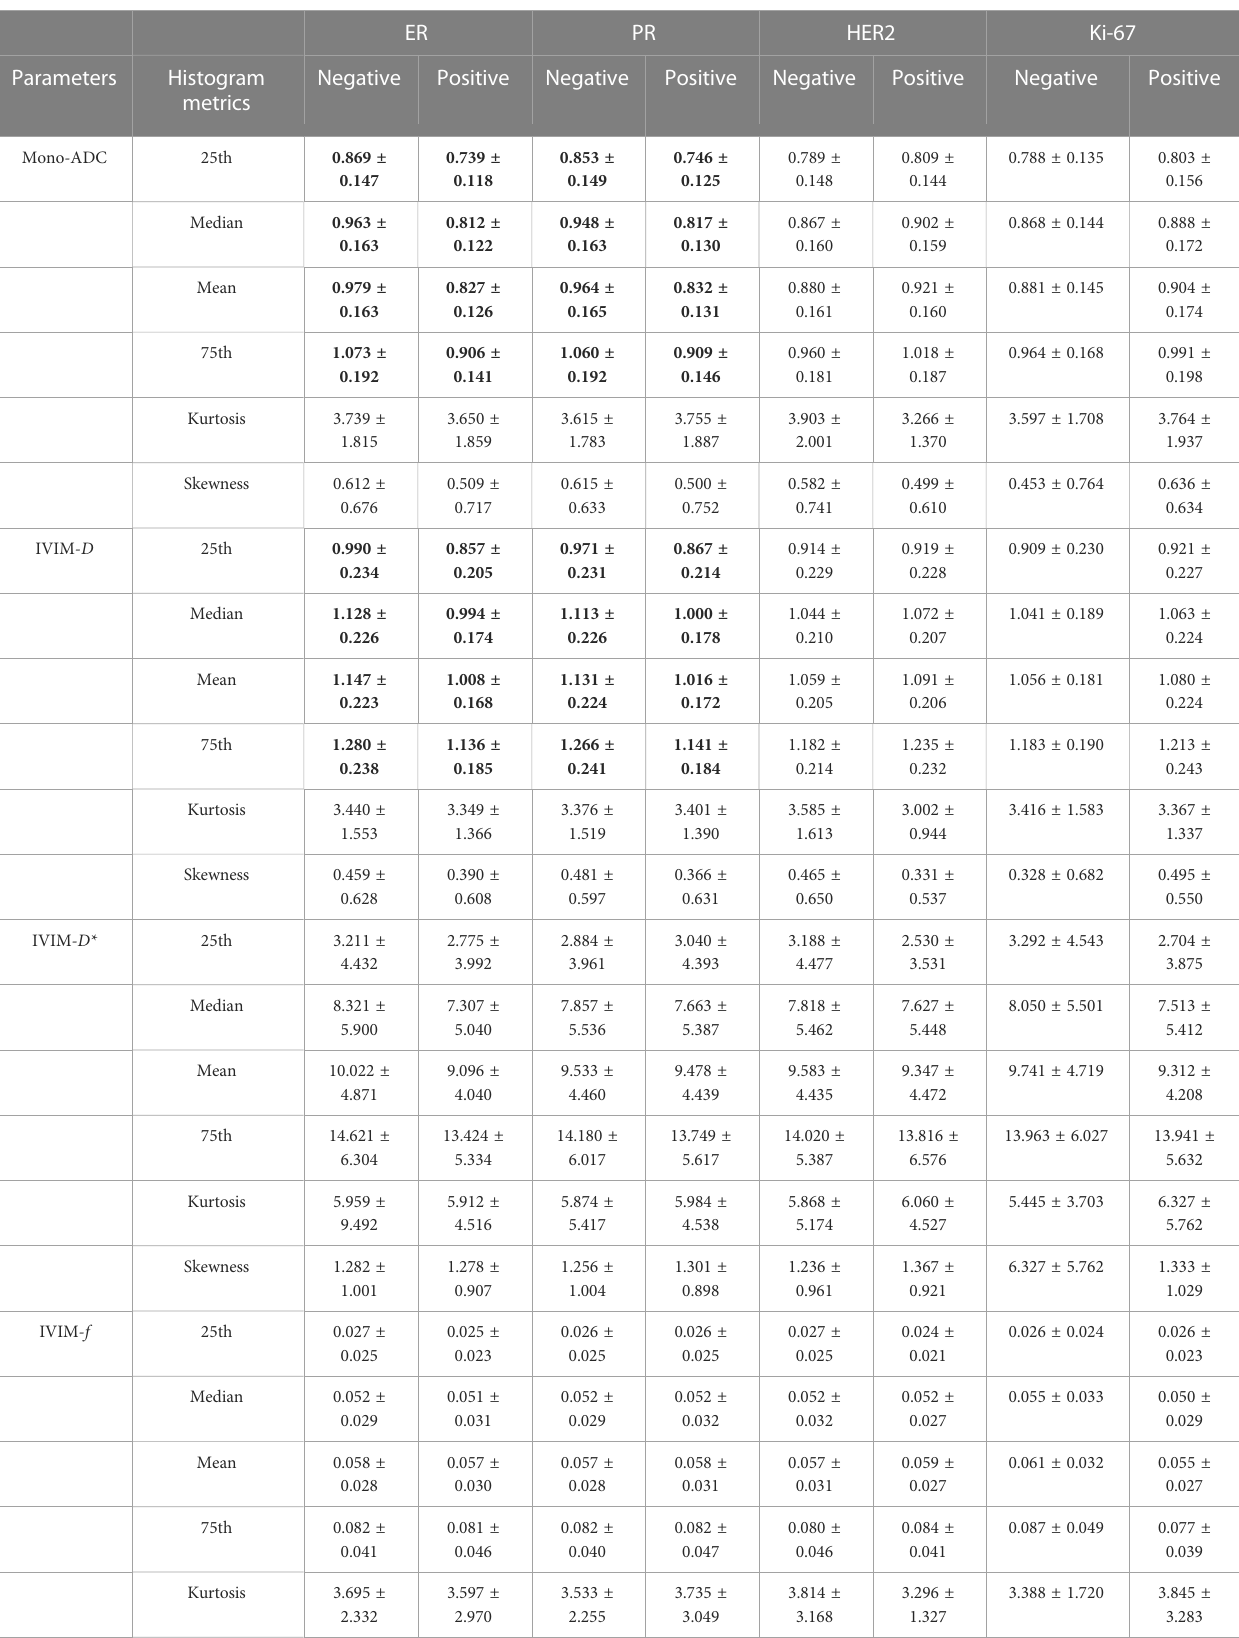
TABLE 4 Comparisons of mono, IVIM and DKI histogram metrics between different groups with molecular prognostic factors and